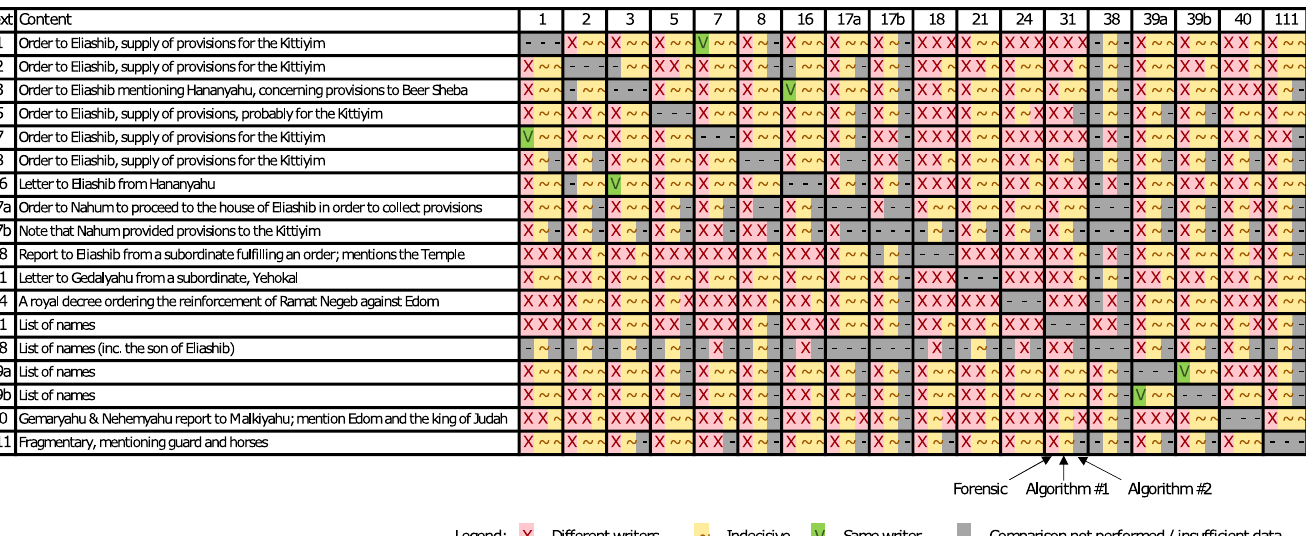
Fig 5. Comparison between different Arad ostraca via forensic and two algorithmic investigations. Three respective results are provided in each intersection in the table.